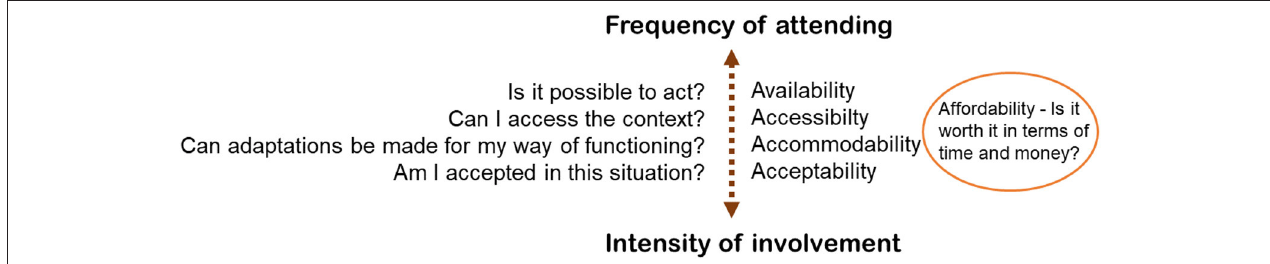
FIGURE 2 | Environmental dimensions of participation (Developed from Maxwell and Granlund, 2011, p. 255).